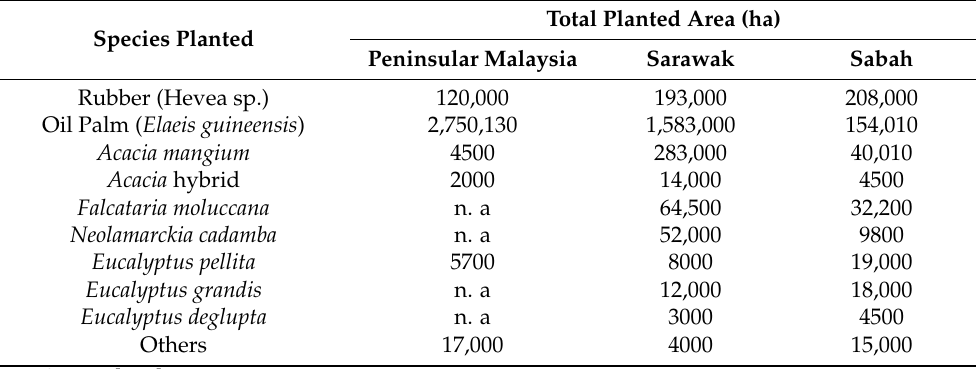
Table 1. Forest Plantation Area in